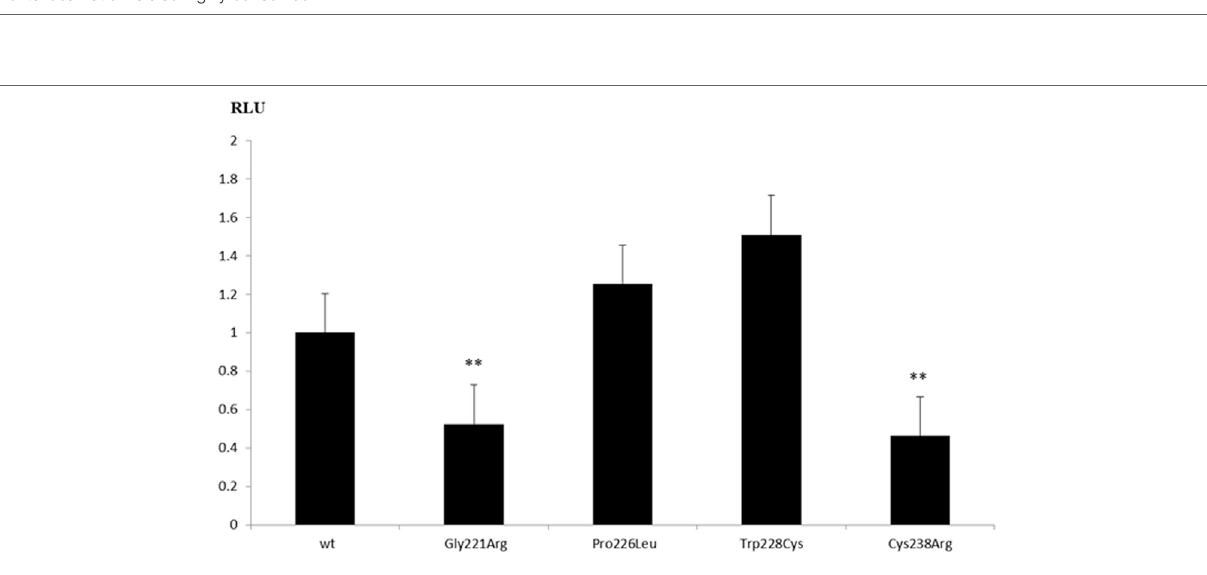
FigUre 3 | Transcriptional activity of GATA4 variants on the CYP17A1 promoter. Human placental JEG3 cells were transfected with a CYP17-promoter luciferase reporter construct, and the activity of wild-type (wt) and mutant GATA4 to trans-activate the promoter was tested using the Promega Dual Luciferase readout system. Results are shown as the mean ± SEM of four independent experiments, all performed in duplicate. ** p -Value ≤ 0.01.